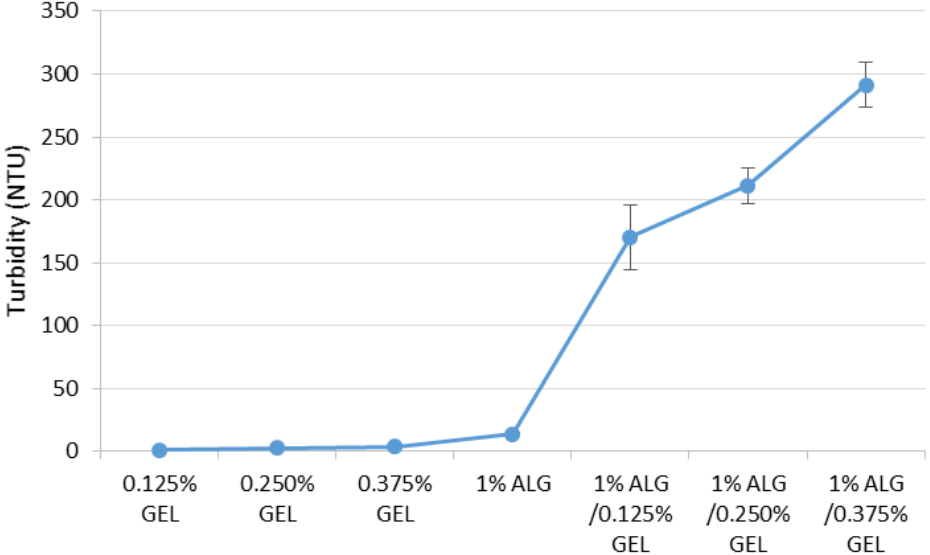
Figure 2. Viscosity values of 0.125%, 0.250%, 0.375% GEL, 1% ALG, and ALG/GEL PECs mixtures with regard to various polyanion/polycation ratios.